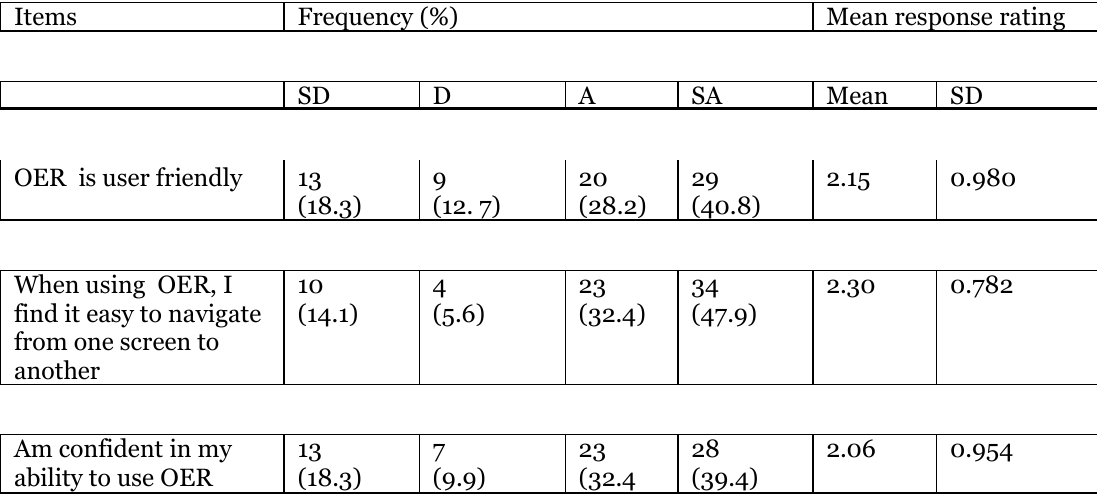
Table 6 reveled that (40.8 and 28.2) agreed that OER is user friendly while (47.9 and 32.4) also found OER easy to navigate. This might have built in them confidence and believe in the use of OER. This also indicates that it is a good condition for students to work